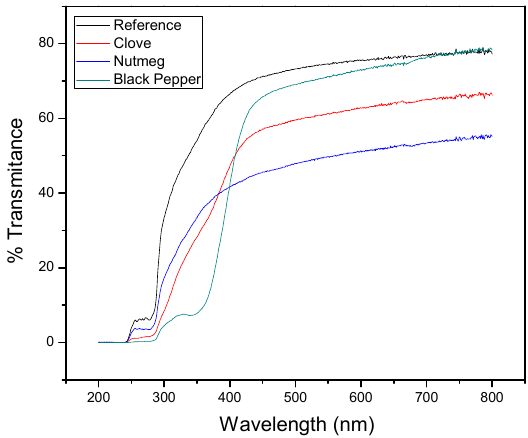
Figure 7. Light transmission of biocomposite films with clove, nutmeg, and black pepper oleoresins and reference (without oleoresin).